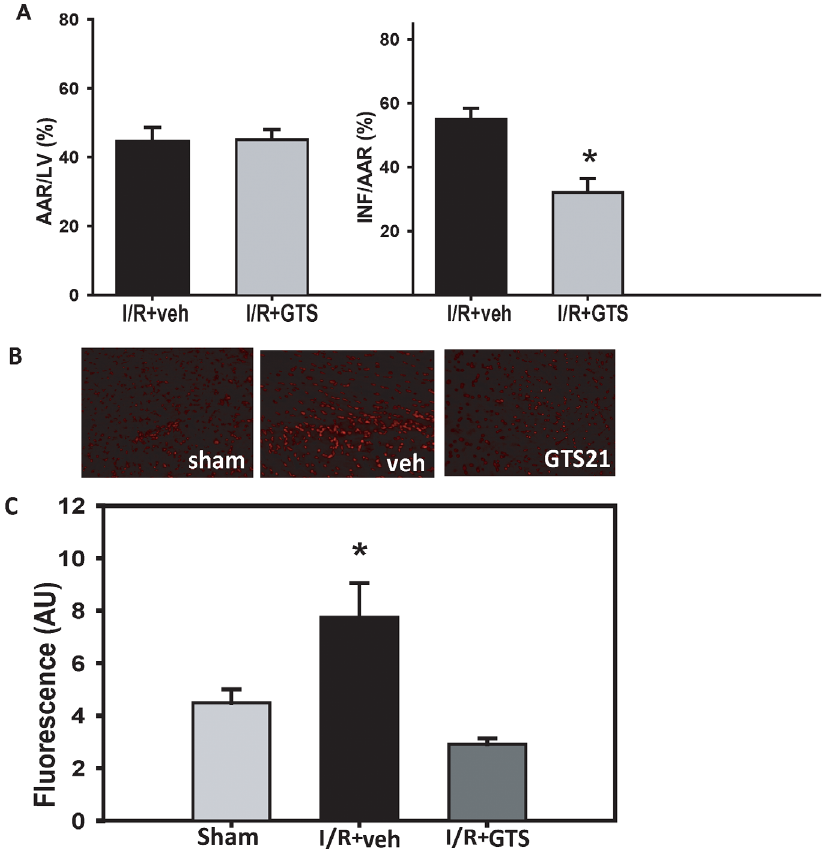
Figure 2. GTS21 treatment at reperfusion reduced infarct size and ROS and improved contractile function in vivo in a rat model of I/R. (A) Myocardial area at risk (AAR) as percent of LV area in rats receiving vehicle (veh, n = 6 ) or GTS21 (GTS, n = 6 ) (no statistical difference between groups); data are mean ± SE. Infarct size (INF) expressed as percent AAR. Statistical significance was determined by Student t test. * p < 0.01 versus I/R + veh. (B) Representative images of DHE staining of 8 μ m frozen sections of LV free wall in sham, I/R + veh and I/R + GTS21 groups; 200 × magnification; excitation wavelength, 551 nm. (C) Quantitation of DHE fluorescence (AU, arbitrary units) in mi- croscopic images using Image Studio Lite v3.1. Staining intensity was measured in three independent areas in three sequential sections per heart. n = 5 hearts/group; bar graph represents group mean ± SE. Statistical significance determined by one-way